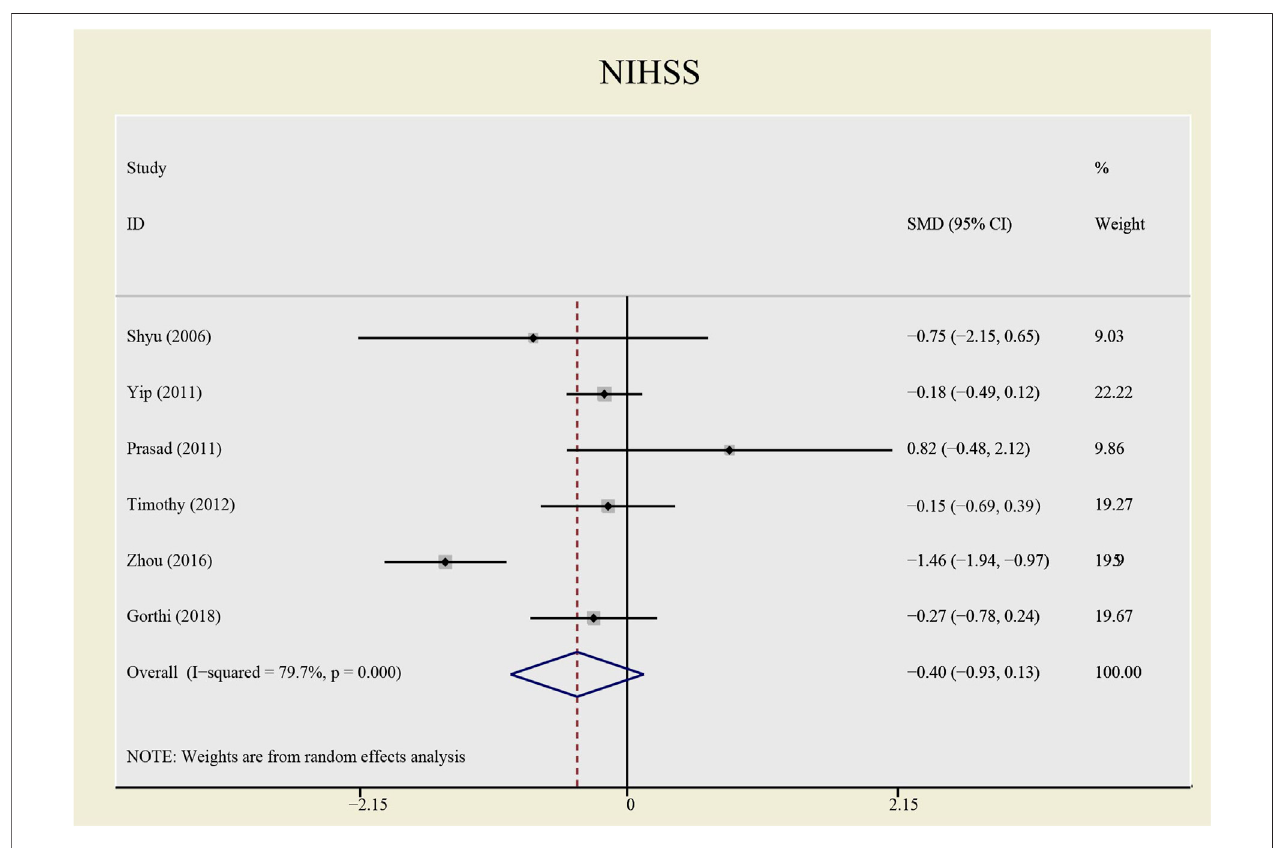
FIGURE 8 | Forrest plot for